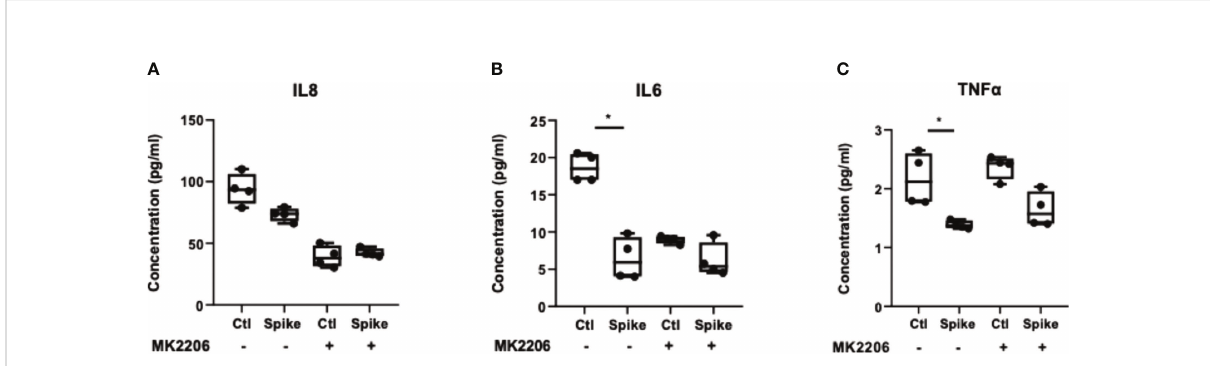
FIGURE 4 Inhibition of AKT abrogated the immunosuppressive action of SARS-CoV-2 S protein. A549 cells were treated with the pan-AKT inhibitor MK2206 (5 m M) for 24 hours and then stimulated with SARS-CoV-2 S (50ng/ml) for 12 hours. Secretion of IL8 (A) , IL6 (B) and TNF a (C) decreased in the presence of SARS-CoV-2 S, an effect which was less evident in MK2206-treated cells. Data are illustrated in bars and plotted as median with range (n=4 biological replicates per group). Statistical analysis was performed with Kruskal - Wallis test. *p < 0.05.